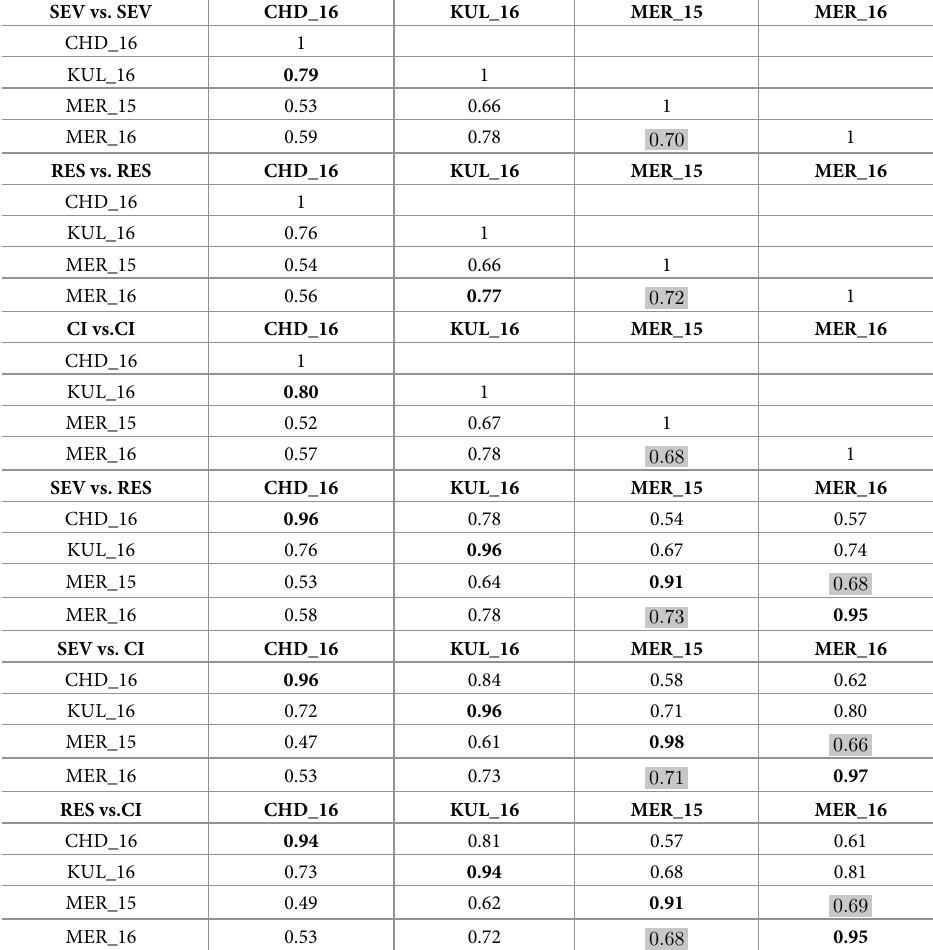
Table 3. Correlation coefficients of SEV, RES and CI values within and among four environments.